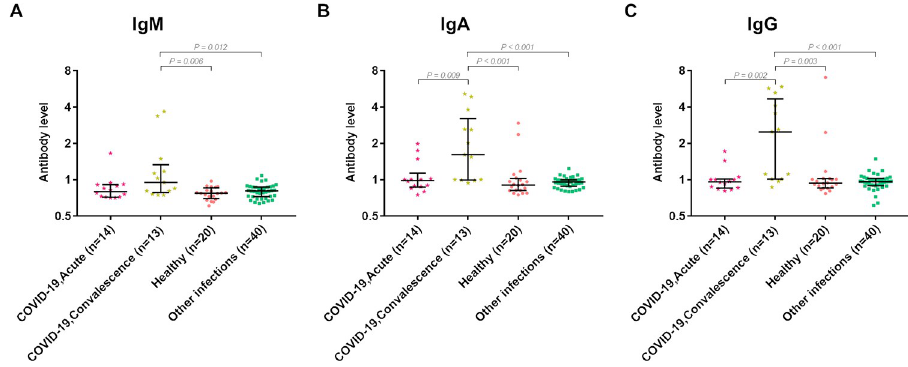
Fig 3. Analysis of classes of antibody responses to RBD in serum samples of acute and convalescent-phase COVID-19 patients, healthy donors and patients with other